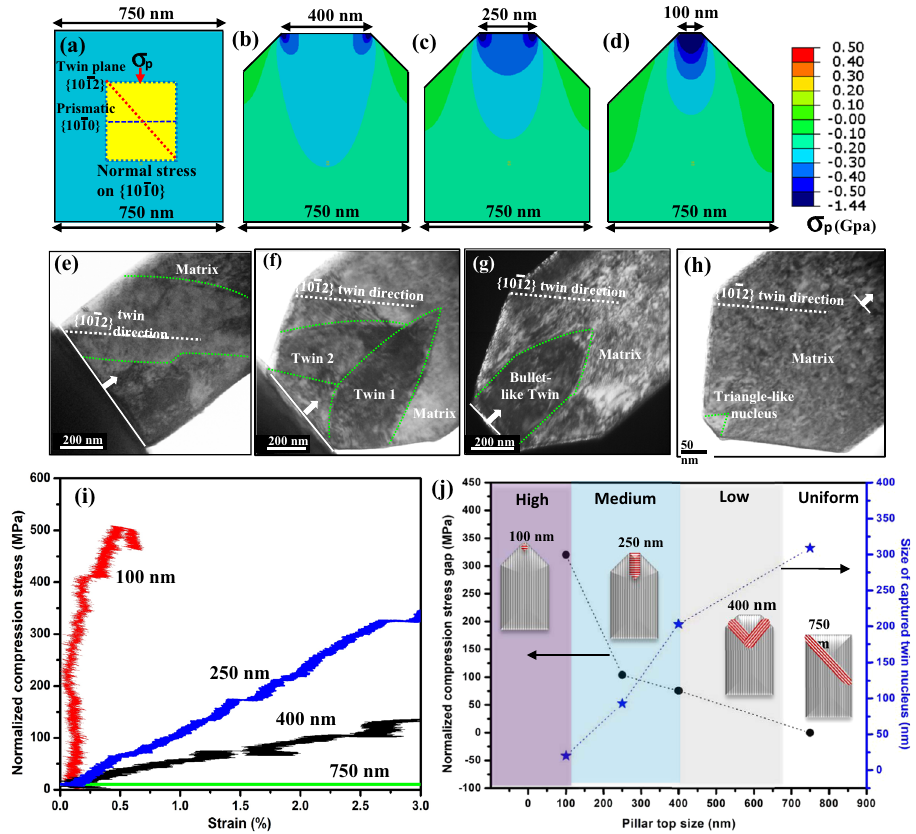
Fig. 1 Twinning behavior and stress fi elds in single-crystal Mg pillars with various geometries. a – d Normal stress on the prismatic planes ( σ p ) and e – h twin morphologies with respect to the pillars: e a gigantic twin lamella within a conventional pillar; f two intersected co-zone twins within a truncated wedge-shaped pillar with 400 nm top; g one bullet-shaped twin within a truncated wedge-shaped pillar with 250 nm top; h one triangle-like twin nucleus within a truncated wedge-shaped pillar with 100 nm top. The arrows in e – h indicate the compression direction. i Normalized compression stress curves for the various pillars with different top sizes for the in-situ tests. The compression stress curves were normalized on the basis of the gap between the averaged stress at the truncated wedge pillar top (max. stress) and averaged stress at the pillar bottom (min. stress) at different strains and were calculated by using the max. stress curves subtracting the min. stress curves, as shown in Supplementary Fig. 3i – l. j Measured normalized compressive stress gap and critical sizes of the captured twin nucleuses at the twin nucleation points as a function of the pillar top width. The data in i , j were derived on the basis of Supplementary Fig.